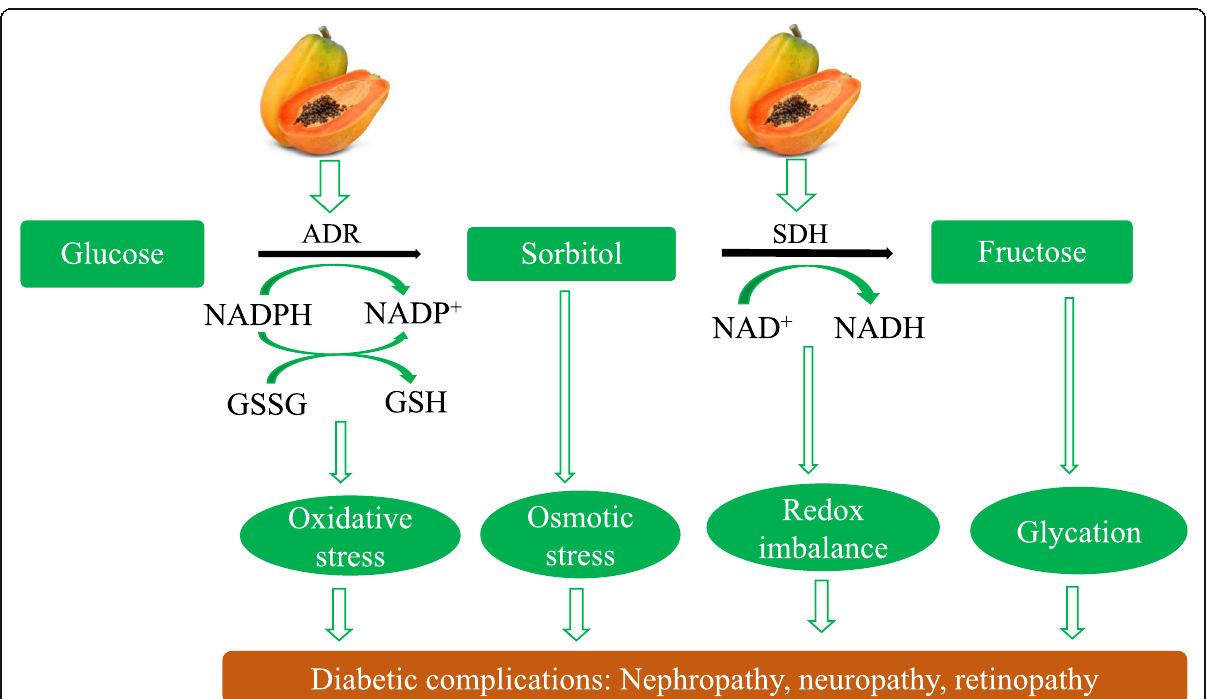
Fig. 3 Possible mechanisms involved in the inhibition of polyol pathway enzymes by pawpaw ( Carica papaya ) extract, and its amelioration of diabetic complications. ADR, aldose reductase; SDH, sorbitol dehydrogenase; GSH, reduced glutathione; GSSG, glutathione disulfide; NADP + , nicotinamide adenine dinucleotide phosphate; NADPH, reduced nicotinamide adenine dinucleotide phosphate; NAD + , nicotinamide adenine dinucleotide; NADH, reduced nicotinamide adenine